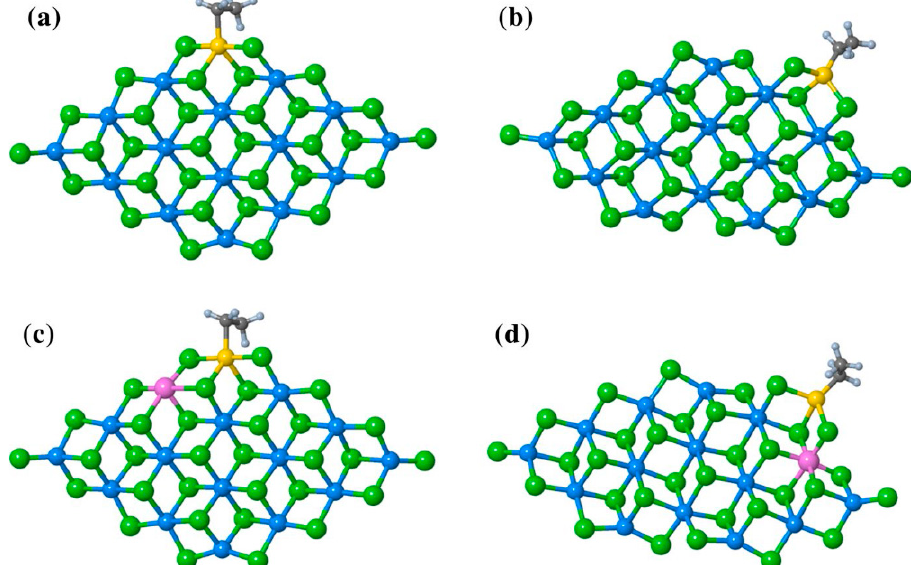
Figure 10. The structure of TiCl 2 Et adsorbed on ( a ) undoped (110); ( b ) undoped (104); ( c ) Al-doped (110); and ( d ) Al-doped (104) surfaces. Reprinted with permission from [117]. Copyright (2022) Springer Nature.